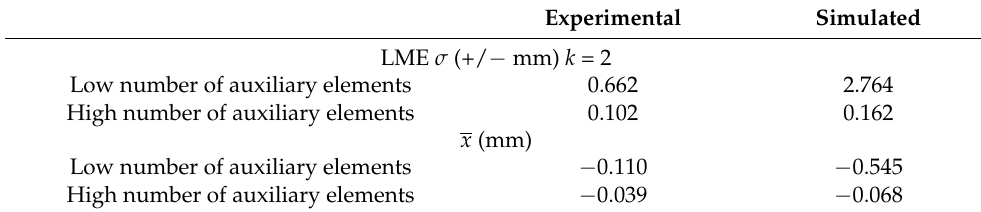
Table 2. Comparison between the experimental results and simulations comparing the influence of auxiliary elements with respect to the standard deviation of the maximum LME and the average of the maximum error. Experimental Simulated LME σ (+/ − mm) k = 2 Low number of auxiliary elements 0.662 High number of auxiliary elements